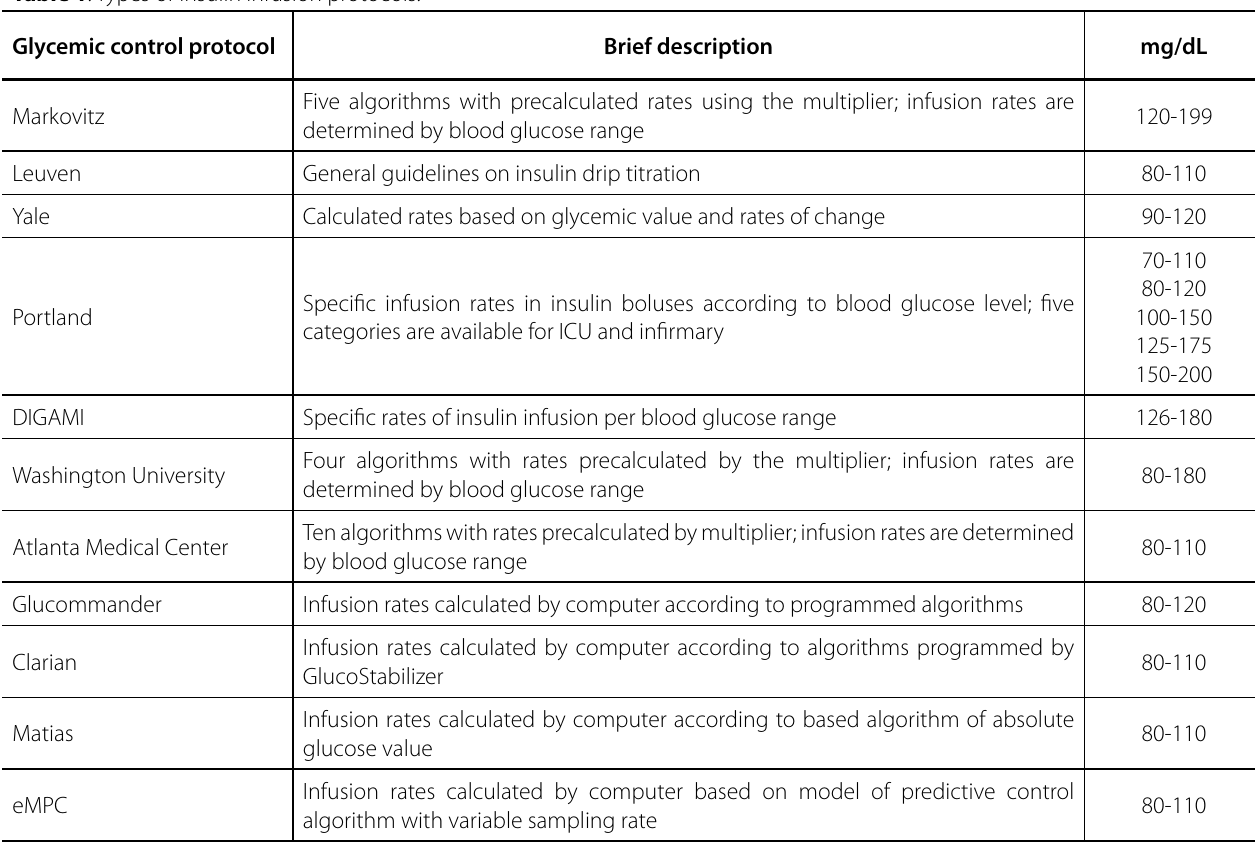
Table 1 . Types of insulin infusion